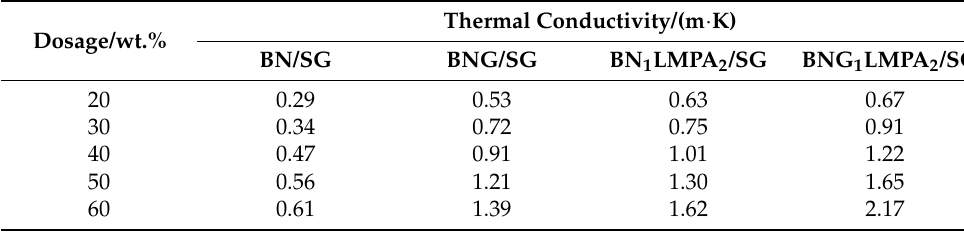
Table 1. Thermal conductivity of different